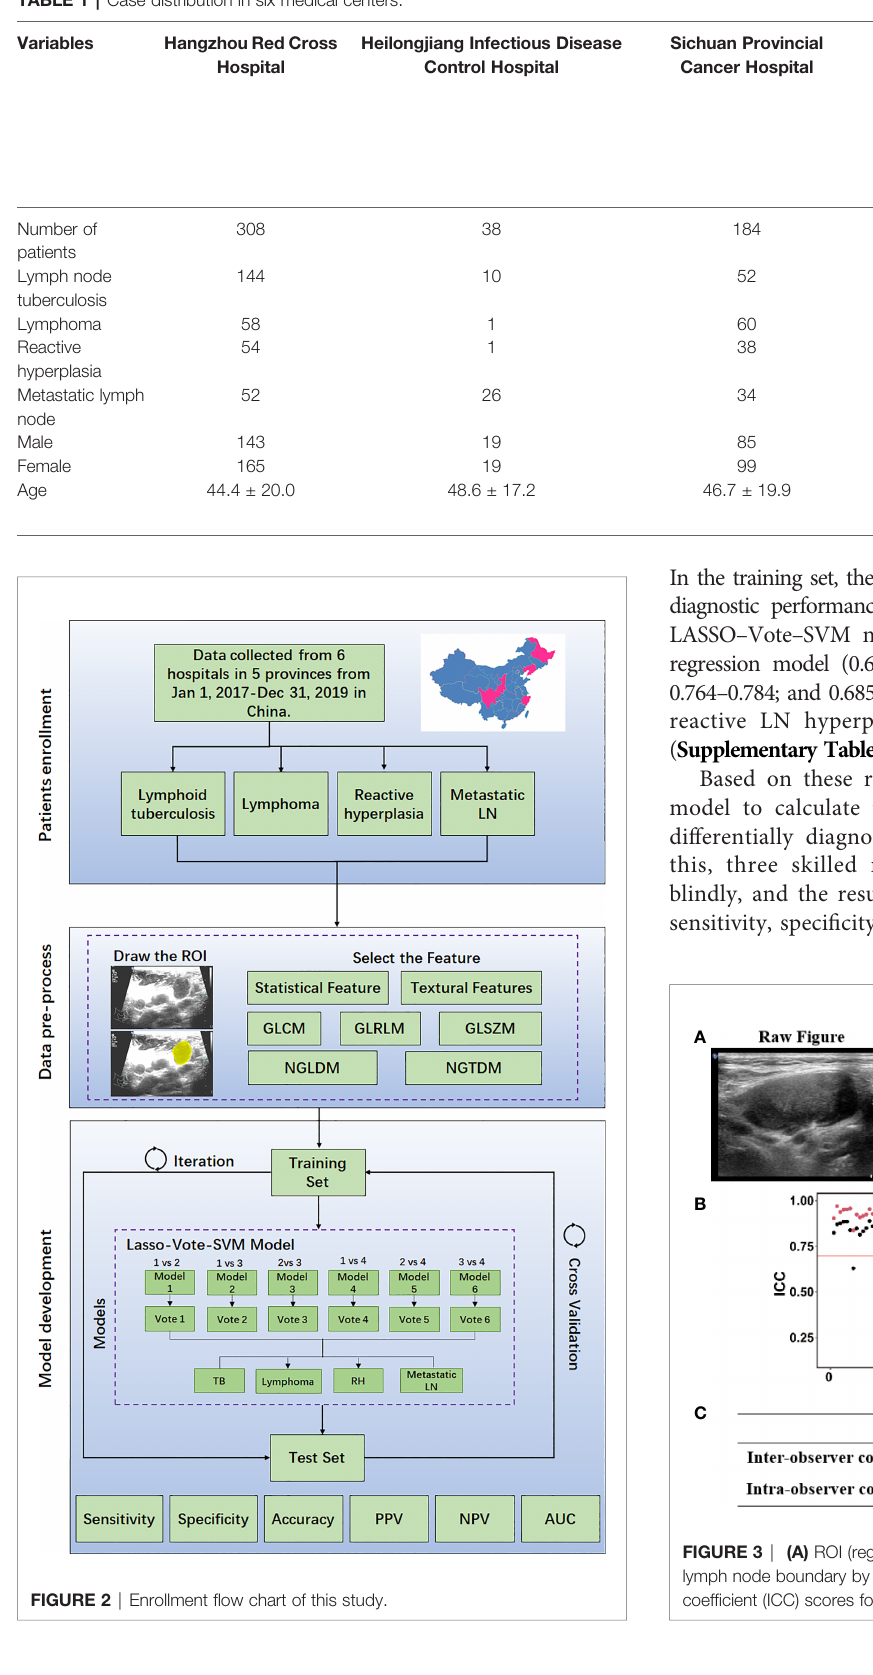
TABLE 1 | Case distribution in six medical